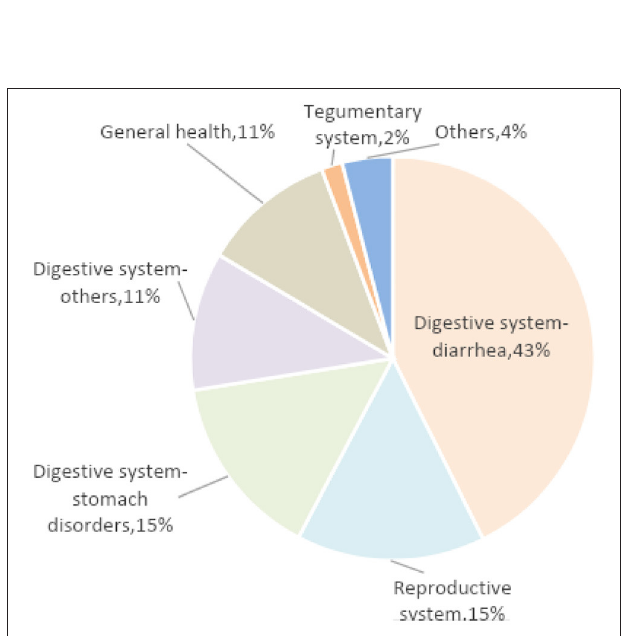
FIGURE 4 | Alluvial graph of the number of ethnoveterinary remedies (colored stripes), country (on the left), and time of use (on the right).